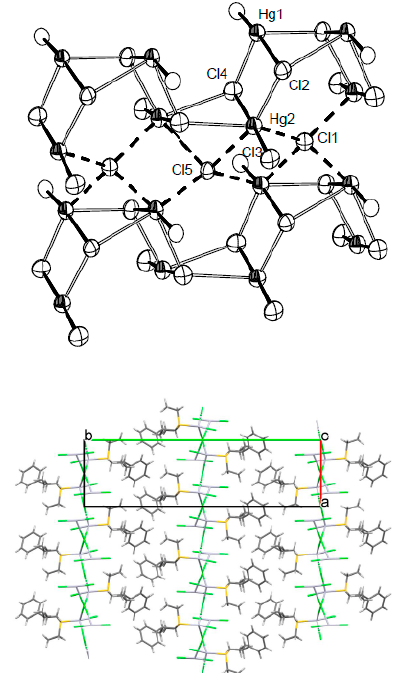
Figure 2. Top: Arrangement of the SHgCl + · HgCl 2 units (black bonds) in puckered ribbons (white bonds), assembled with the assistance of Cl1 and Cl5 anions (dashed bonds). Bottom: polymeric chains viewed along the c axis.